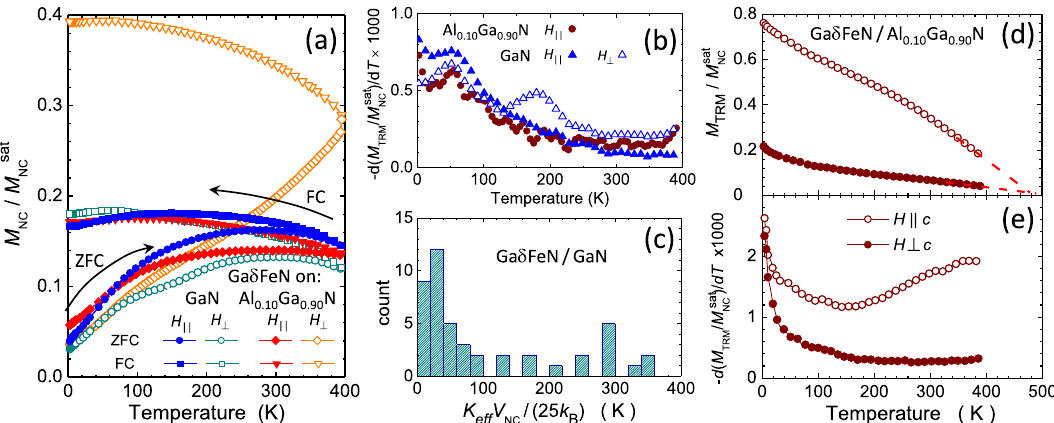
Figure 9. ( a , b ) ZFC, FC and the calculated temperature derivative of the thermoremanence magnetization (TRM): − d ( M FC − M ZFC ) dT in the studied Ga δ FeN structures grown either on GaN or on the Al 0.1 Ga 0.9 N buffer. ( c ) Superparamagnetic limit distribution in the Ga δ FeN/GaN structure calculated based on the size and shape distributions of the NCs taken from Figure4a. ( d ) Direct measurement of TRM in Ga δ FeN/Al 0.1 Ga 0.9 N after cooling down in a saturating H = 10kOe and ( e ) its T –derivative. The dashed lines in ( d ) point to the superparamagnetic limit of about